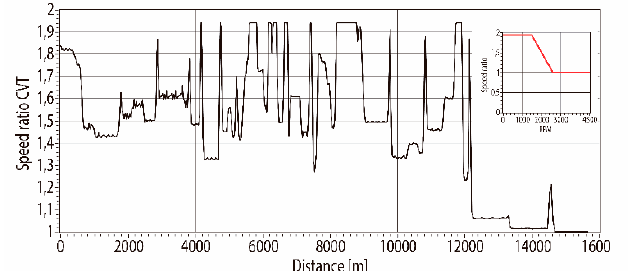
Figure 22. CVT speed ratio during the route.